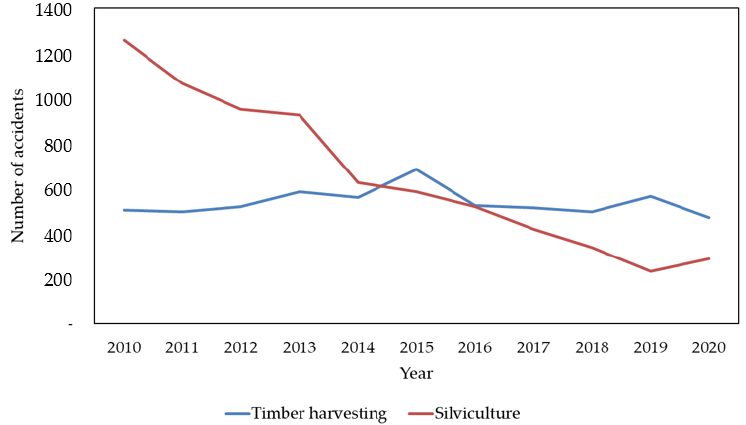
Figure 5. Distribution of occupational accidents by operation type.